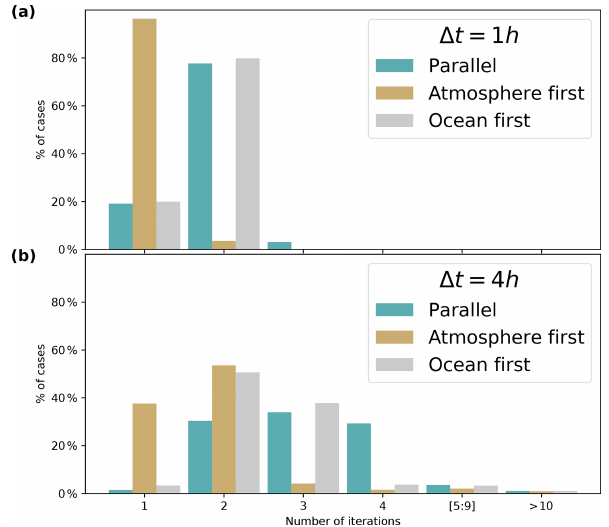
Figure 4. Number of iterations for convergence for the ( a , top) (cid:49)t = 1h and ( b , bottom) (cid:49)t = 4h experiments. The total number of cases is 536800 = 120 Schwarz windows × 4553 ice-free grid points in the (cid:49)t = 1h experiments and 136800 = 30 Schwarz win- dows × 4560 ice-free grid points in the (cid:49)t = 4h experiments. This number of cases is given for the parallel algorithm and slightly dif- fers for the other algorithms. The ordinates show the number of cases as a percentage of the total number of cases in time × space.